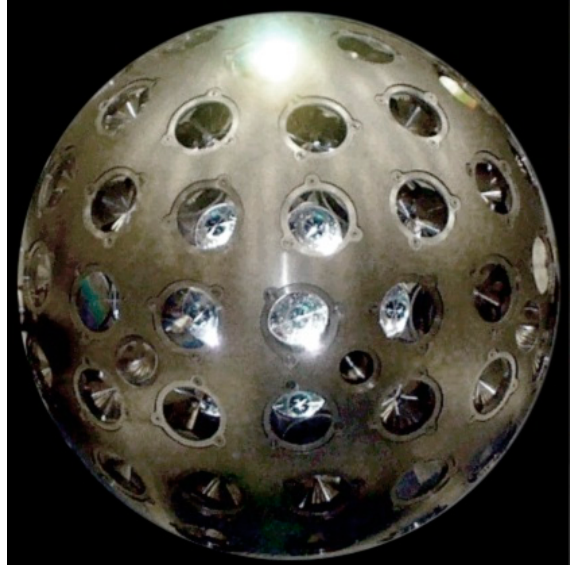
Figure 1. LAser RElativity Satellite (LARES). http://www.lares-mission.com/foto.asp. The LARES satellite, built by the Italian Space Agency (ASI), was launched on 13 February 2012 from the ESA Kourou Center in French Guiana using the Vega VV01 rocket. The satellite is moving in a circular orbit at a distance of 1450 km with an inclination of 69.5 degrees over a period of 1.9 h. The satellite is only intended for laser observations. It is a sphere with a diameter of 36.4 cm and a mass of 386.8 kg (the densest object in the solar system). On the surface it has 92 corner cube retroreflectors with a diameter